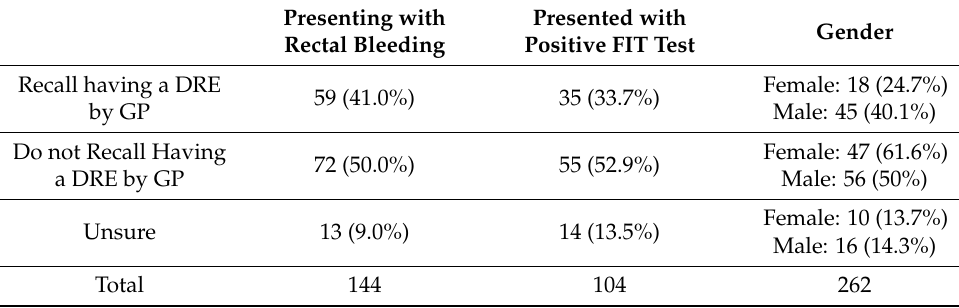
Table 2. Number of patients who recalled having had a DRE.